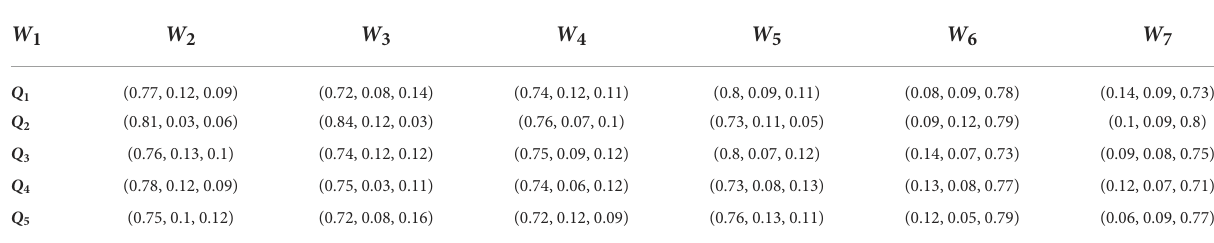
TABLE 2 Decision matrix given by the second expert E 2